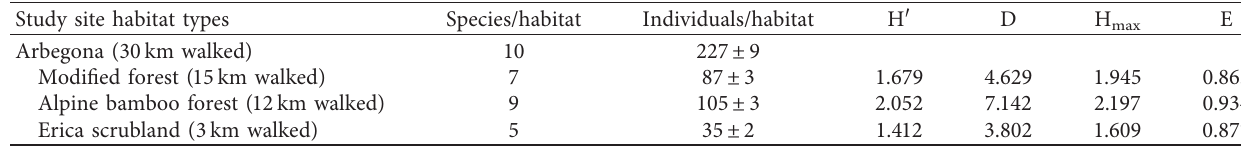
Table 2: Diversity indices of large wild mammal’s indifferent habitat types of Geremba Mountain, southern Ethiopia.